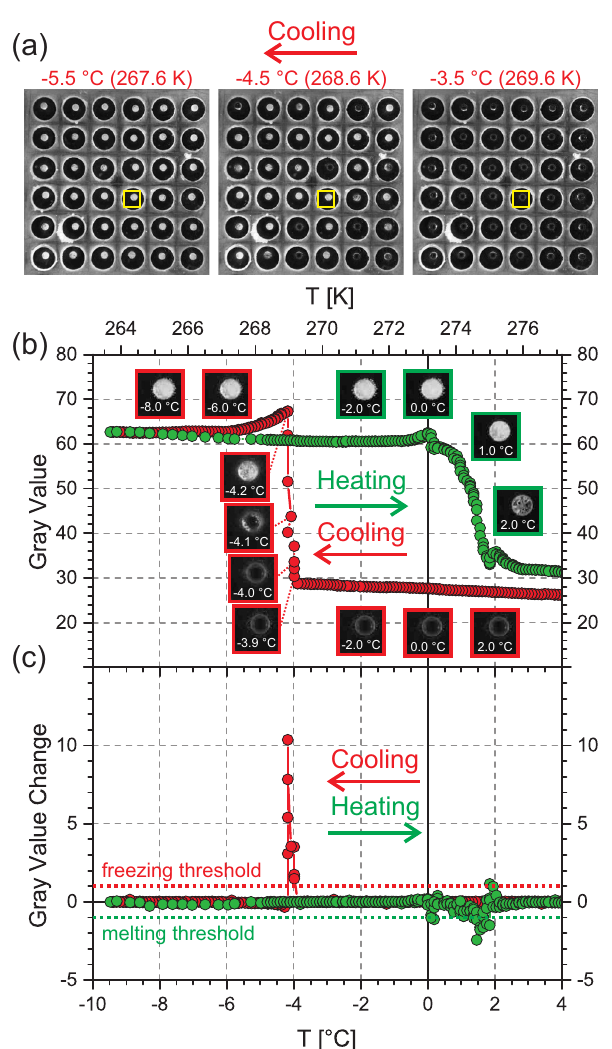
Figure 2. Example experiment with Snomax ® -containing droplets (0.1µgdrop − 1 ) describing the automatic detection of nucleation events by the change in brightness during freezing. A video of this experiment is available in the Supplement. (a) Image series of the 6 × 6 droplet array during cooling. (b) Measured gray value of the compartment/droplet indicated by the yellow box in panel (a) dur- ing cooling (red) and heating (green). Freezing and melting start at − 3.9 ◦ C (269.3K) and 0.0 ◦ C (273.2K), respectively. (c) Plot of the change in gray value between successive images showing peaks at the phase transition points. Threshold values of ± 1 for the au- tomatic attribution of freezing and melting are indicated by dashed